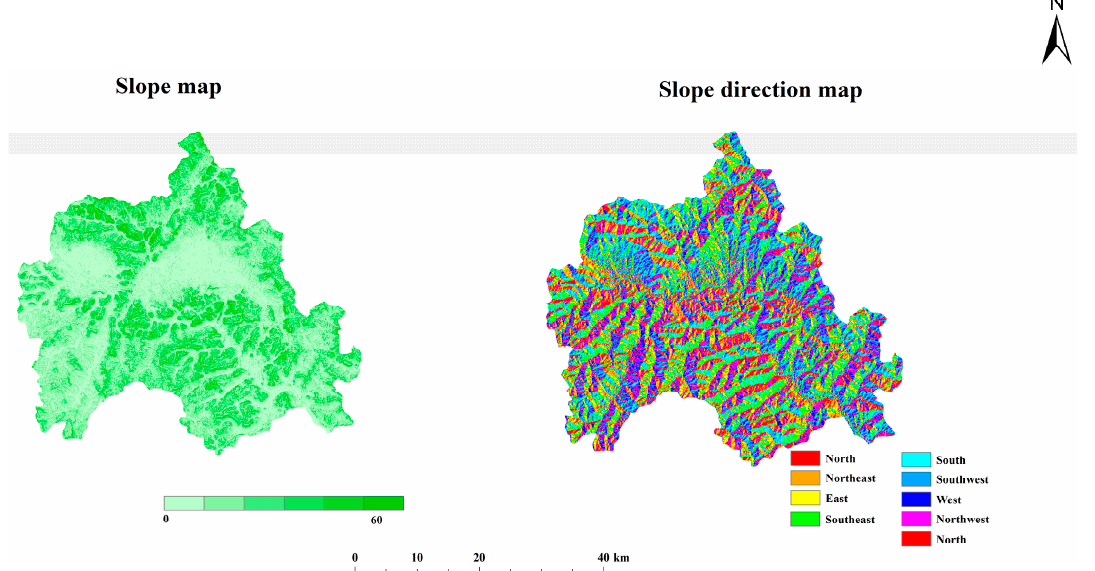
Figure 1. Overview of the study area. The blue part shows the topographic elevation distribution of the study area.